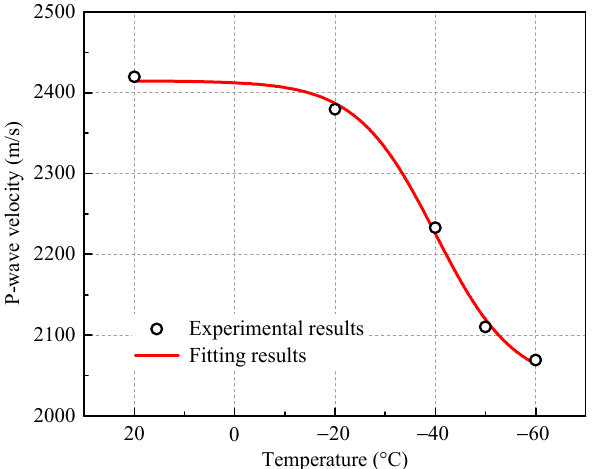
Figure 4. Variation of P-wave velocity with freezing temperature.